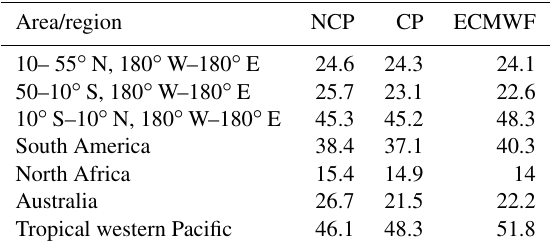
Table 1. Mean precipitable water (PW) content (mm) averaged over different regions. Column one denotes the averaging region, fol- lowed by the NCP, CP, and ECMWF